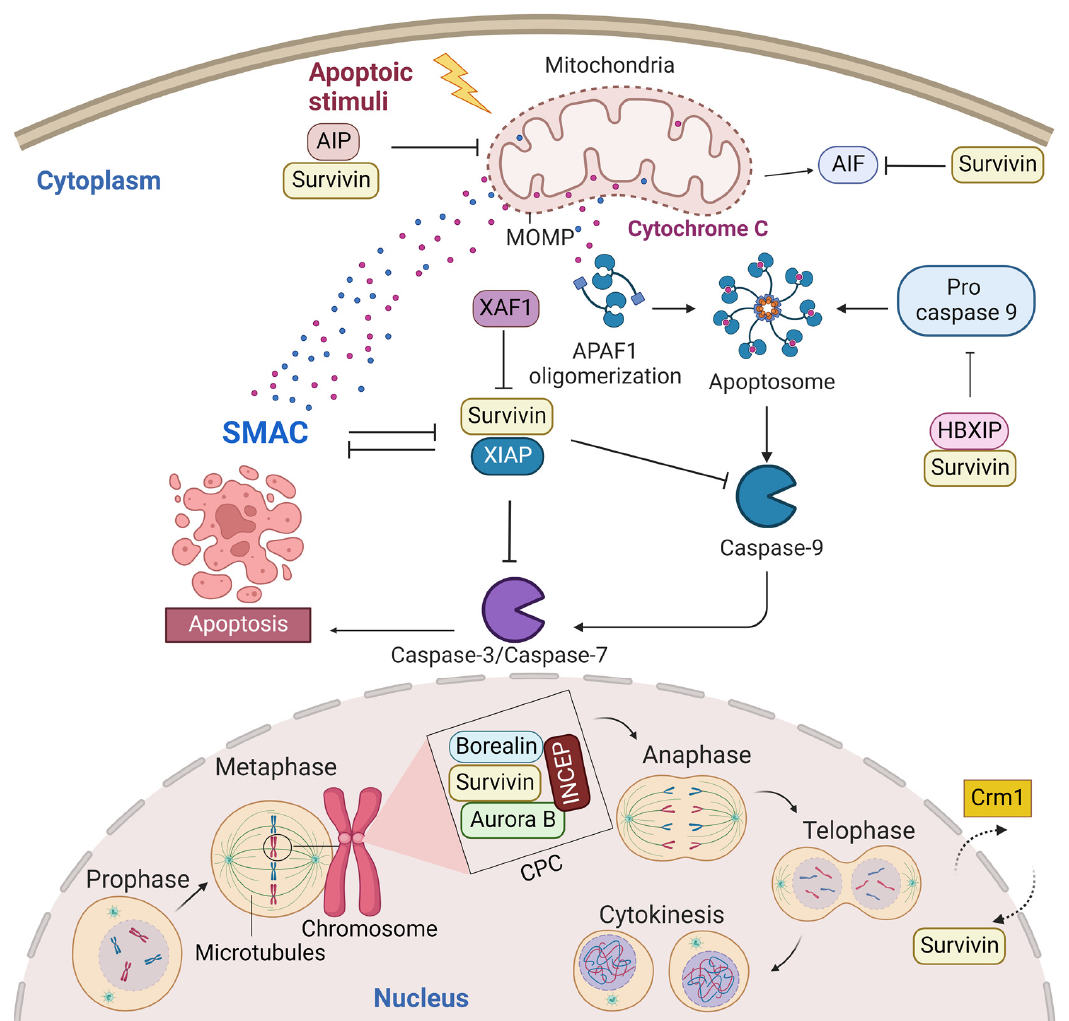
Figure 2. Survivin is an antiapoptotic protein and essential mitotic protein. Cytoplasmic survivin and mitochondrial survivin inhibit apoptosis, while nuclear survivin regulates cell division. Crm1 mediates the exportation of survivin from the nucleus to the cytoplasm. Survivin plays a significant role in inhibiting the intrinsic apoptotic pathway. The intrinsic apoptotic pathway is activated by endogenous stress signals or irradiation and depends on the release of Cyt-c from the mitochondria.